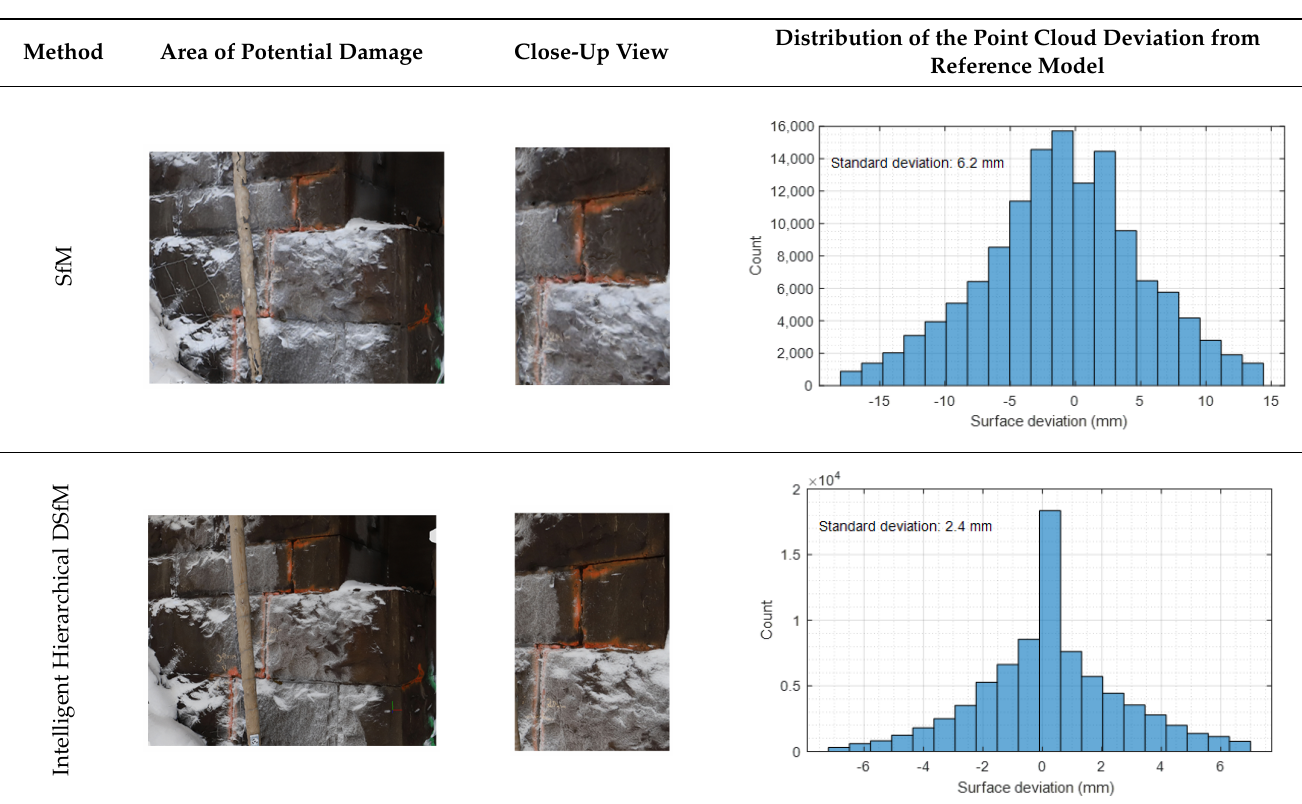
Figure 20. 3D point clouds generated by CRP ( a ) and laser scanning ( b ) which is considered as a reference model, together with detected regions of damage in both. Table 6. Deviation in point clouds generated by both regular SfM and the proposed method, corresponding to the point cloud generated from laser scanning